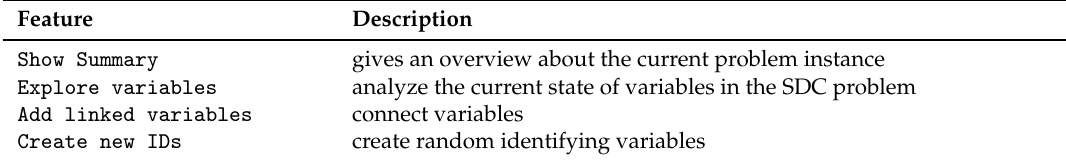
Table 4. Analyze/view the statistical disclosure control (SDC) problem